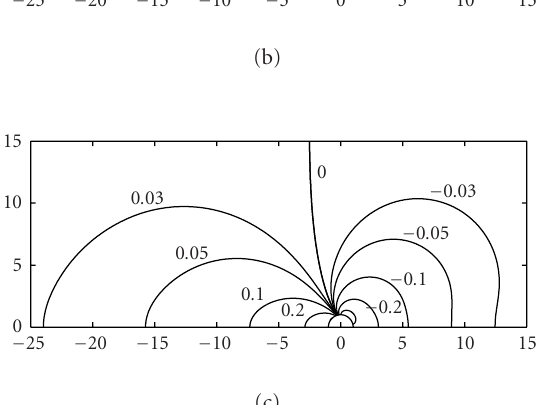
For very low values of N ( < 0 . 1), the drag coe ffi cient decreases when compared to the no field case. This is in agreement with Bramely [3, 4]. The drag coe ffi cient increases with further increase of the magnetic field. The pressure drag coe ffi cient ( C P ) and viscous drag coe ffi cient ( C V ) versus interaction parameter is shown in Figure 4.13. The total drag coe ffi cient versus interaction parameter and the drag coe ffi cient versus Re is presented in Figure 4.14. The pressure drag coe ffi cient C P and the total drag coe ffi cient C D are found to √ N for N ≥ 4. This behavior can be seen in Figure 4.8. The linear dependence vary with √ N of the pressure drag coe ffi cient and total drag coe ffi cient is in accordance with